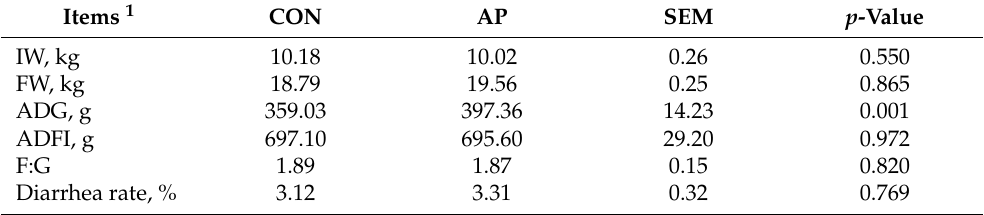
Table 3. Effects of fermented AP (apple pomace) on growth performance of weaned piglets.